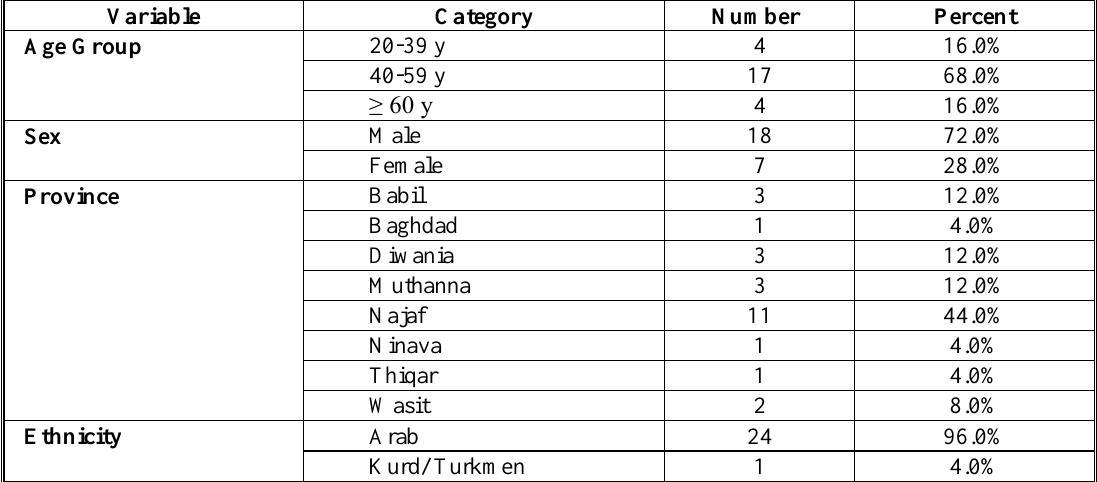
Table 1. Demographic data and patient